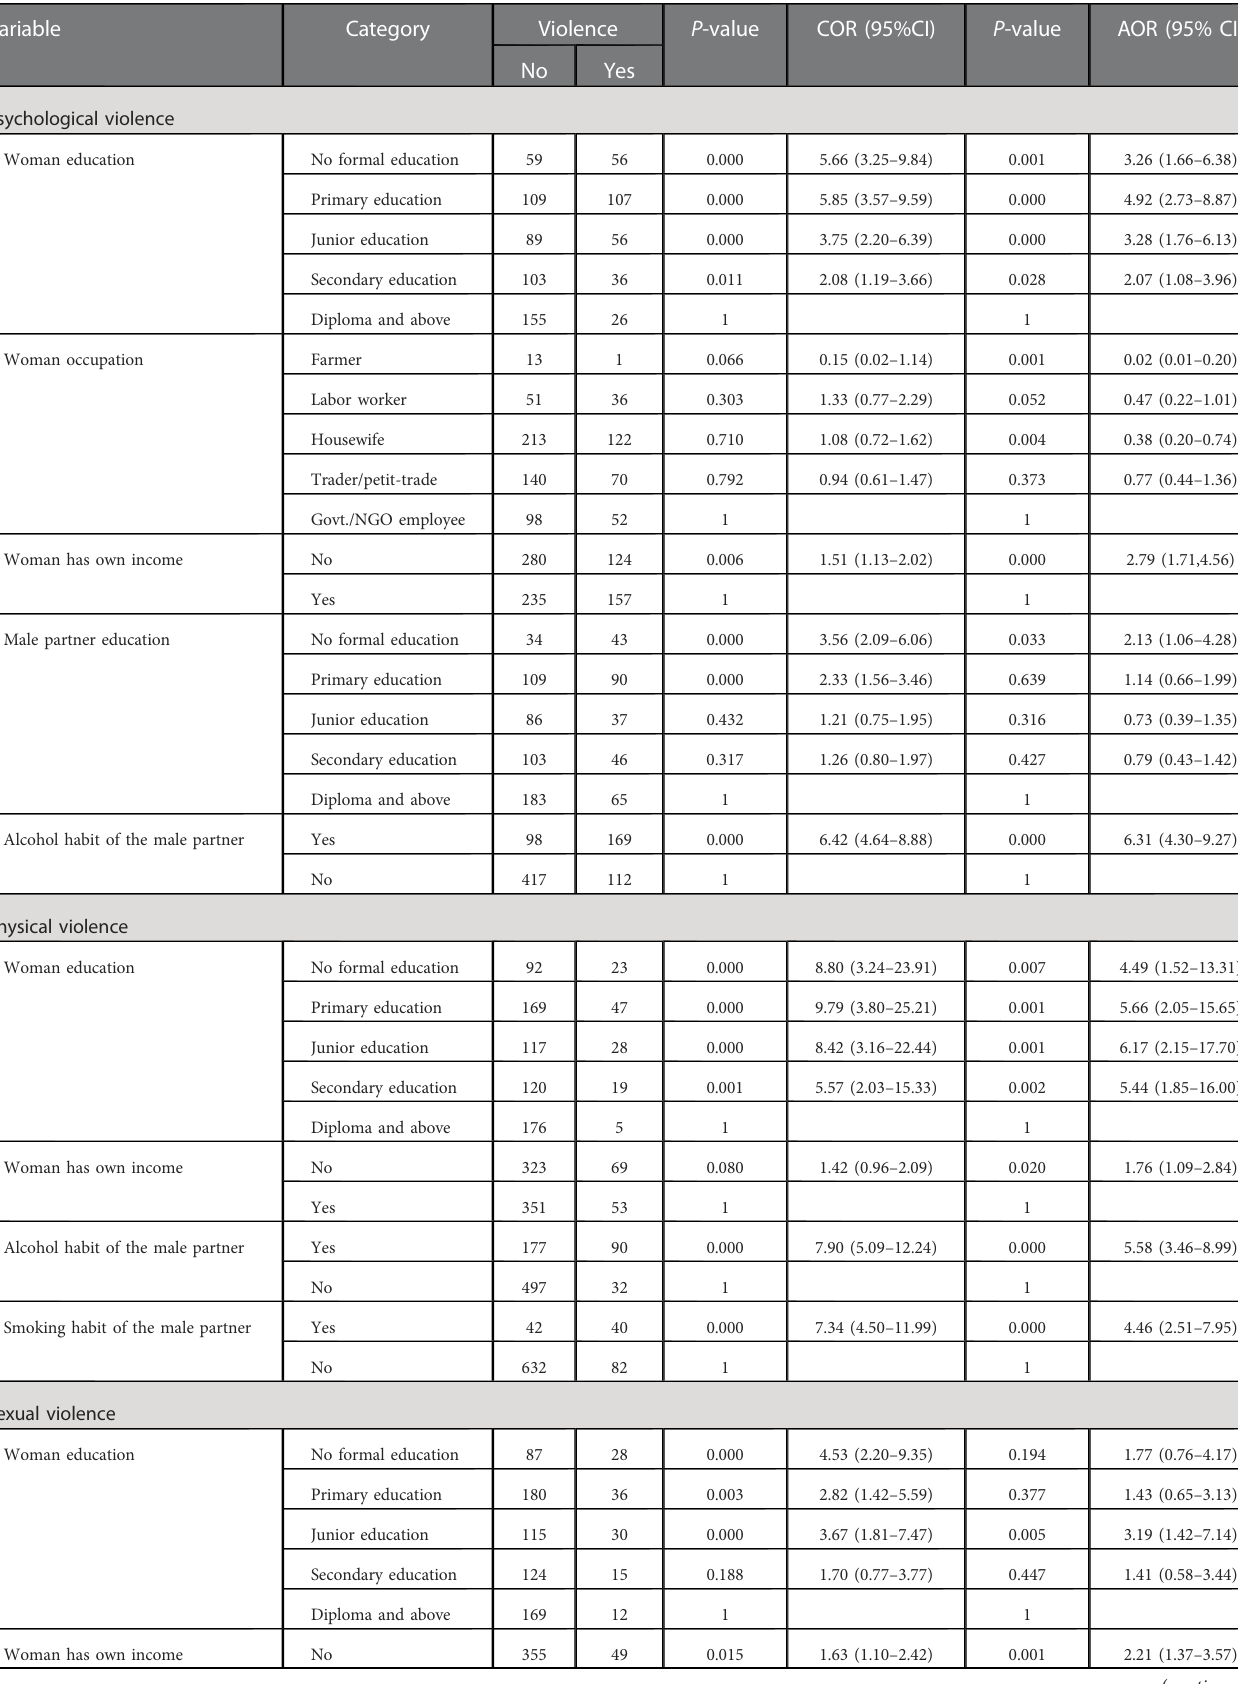
TABLE 9 Bivariate and multivariate logistic regression analyses of the association of factors with each type of IPV among women of reproductive age in Debre Berhan, 2021 ( n =796).